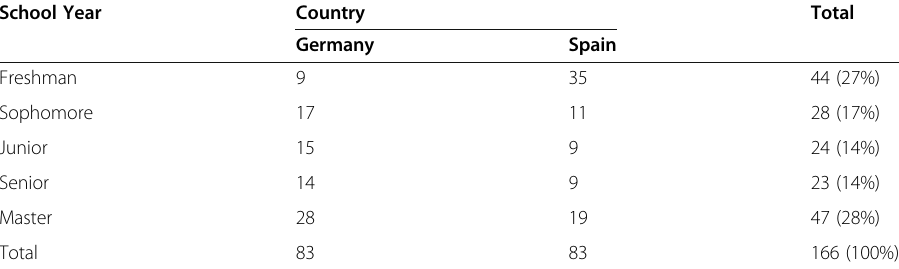
Table 2 School year versus country data of the participants